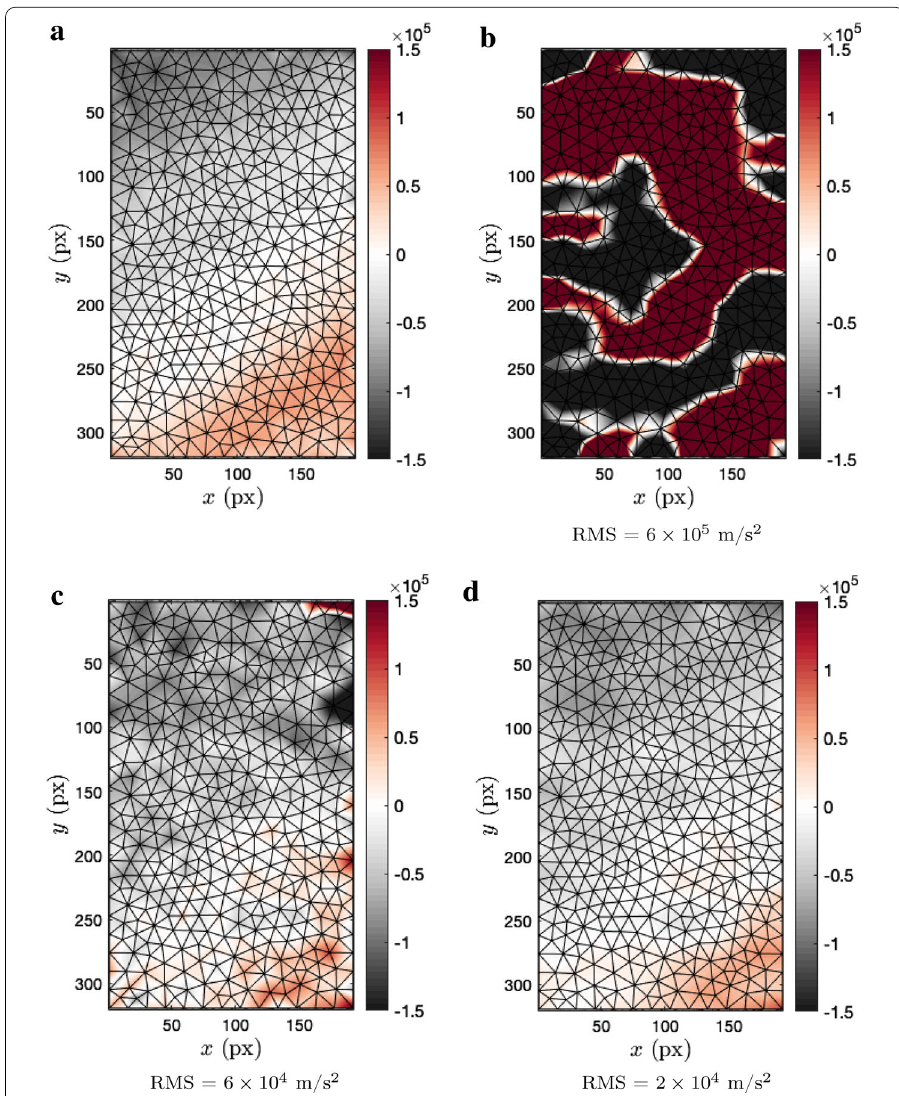
Fig. 8 Acceleration fields along x at t = 85 µ s. a Reference solution, b instantaneous DIC, c spatiotemporal DIC, d dynamically regularized DIC ( (cid:8) D = 75 pixels). The spatiotemporal analysis with no